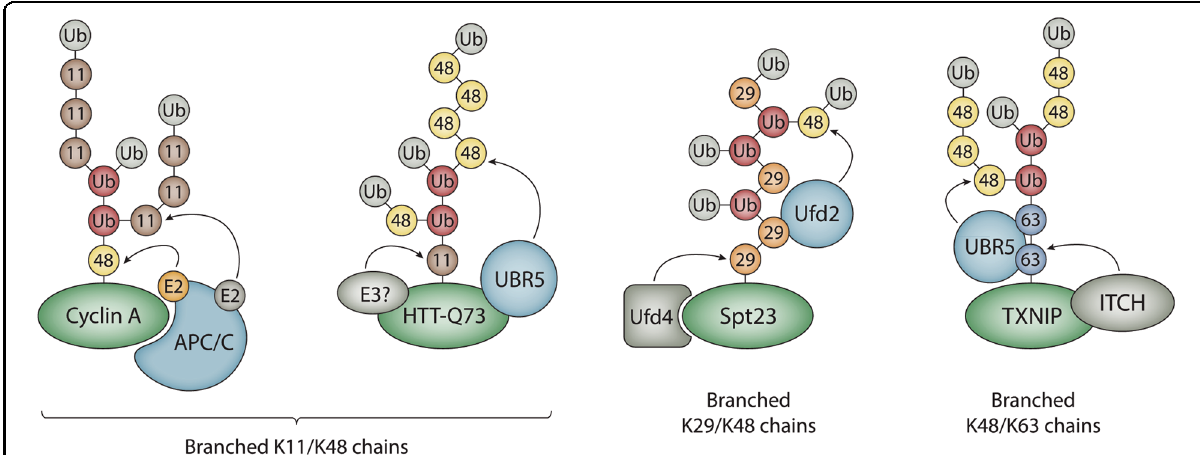
Fig. 2 Architecture and synthesis of branched ubiquitin chains. The APC/C collaborates with two different E2s, UBE2C and UBE2S, to assemble branched K11/K48 chains on cyclin A and other mitotic substrates. UBR5 collaborates with an unknown K11-speci fi c E3 to form branched K11/K48 chains of a different architecture on a pathological mutant version of the Huntingtin protein (HTT-Q73). UBR5 has also been reported to synthesize branched K11/K48 chains on newly synthesized misfolded polypeptides 11 . Spt23 and substrates of the ubiquitin fusion degradation pathway are modi fi ed with branched K29/K48 chains synthesized by Ufd4 and Ufd2. ITCH cooperates with UBR5 to assemble branched K48/K63 chains on the pro-apoptotic regulator TXNIP. Substrates are colored in green; chain branching E3s are colored in light blue; the color coding for ubiquitins is as described in Fig.